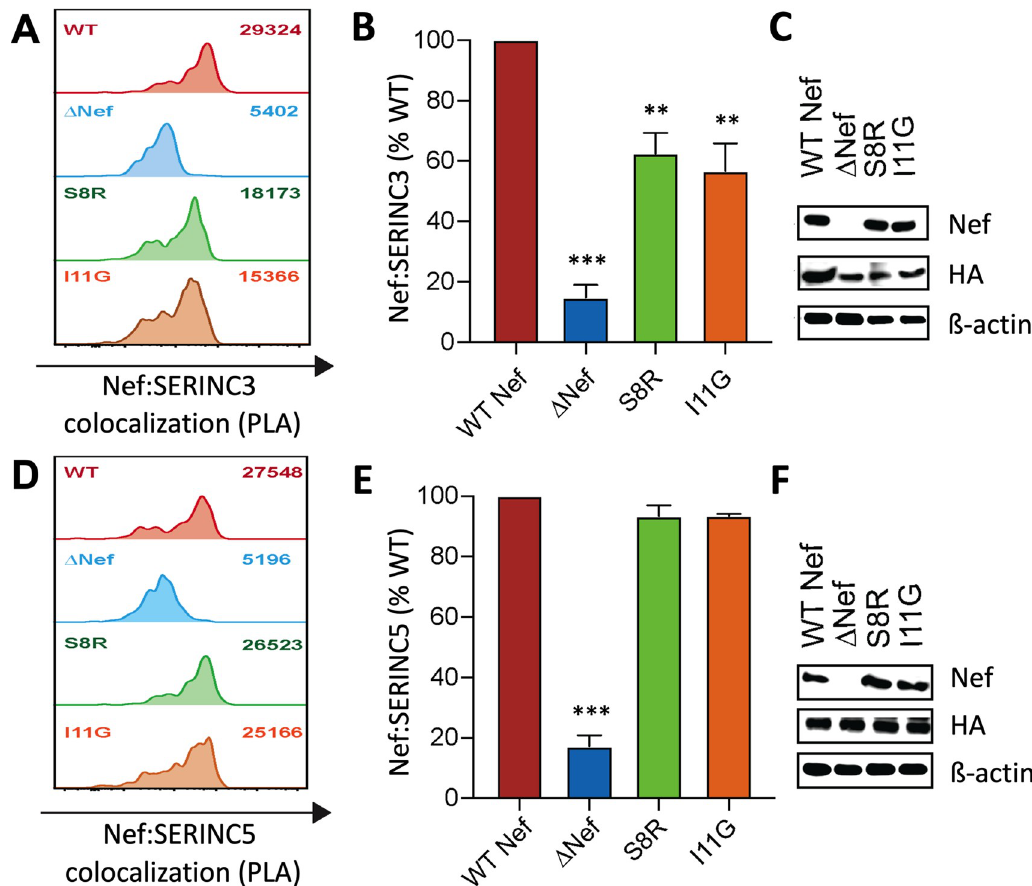
Fig 5. Polymorphisms at Nef residues 8 and 11 selectively impair SERINC3 co-localization. Flow cytometry-based proximity ligase assays (PLA) were used to detect co-localization of Nef with SERINC3(iHA) or SERINC5(iHA), as described in the Methods . ( A ) Histograms display PLA signal (median fluorescence intensity, MFI; upper right) for CEM T cells co-transfected with SERINC3(iHA) and either WT Nef (NL4.3), empty vector ( Δ Nef), Nef S8R or Nef I11G mutants. (B) Normalized PLA values for Nef and SERINC3 co-localization, relative to WT Nef, are shown. (C) Steady-state protein expression is shown for Nef (top) and SERINC3(iHA) (middle), determined by Western blot using the same anti-Nef and anti-HA antibodies as used in PLA. Cellular β -actin was included as a loading control (bottom). The results for similar studies using SERINC5(iHA) are shown, with representative PLA histograms ( D ), normalized PLA values ( E ) and protein expression ( F ) displayed. Results shown in ( A ) and ( D ) are representative of data collected in at least three independent experiments, each done in triplicate. Statistical analyses (unpaired Students T test) were conducted using median values from independent experiments. Significant differences compared to WT Nef are indicated by asterisks ( �� = p < 0.01; ��� = p <